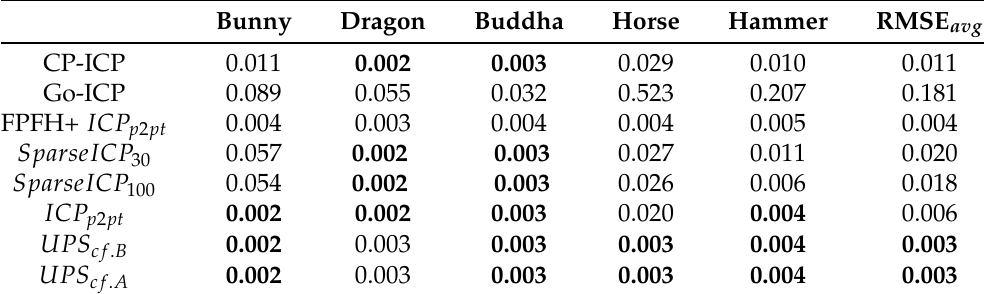
Table 4. RMSE measure after pose correction under known ground truths (in meters). Bunny Buddha